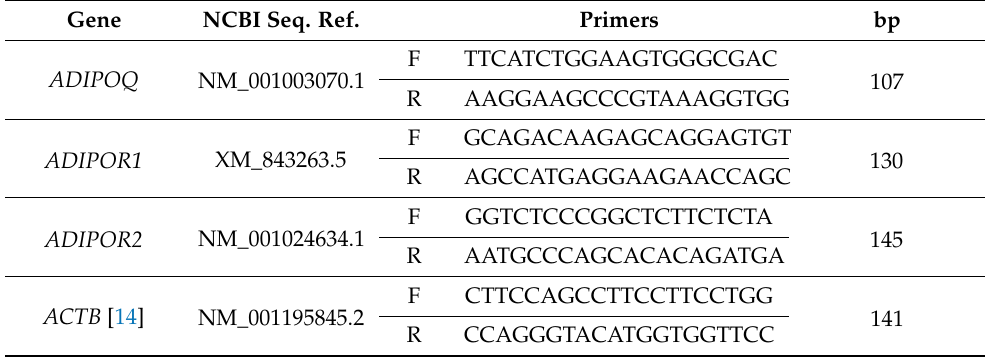
Table 1. Primers for ADIPOQ , ADIPOR1 , and ADIPOR2 housekeeping gene used for RT-qPCR quantification. Gene NCBI Seq.